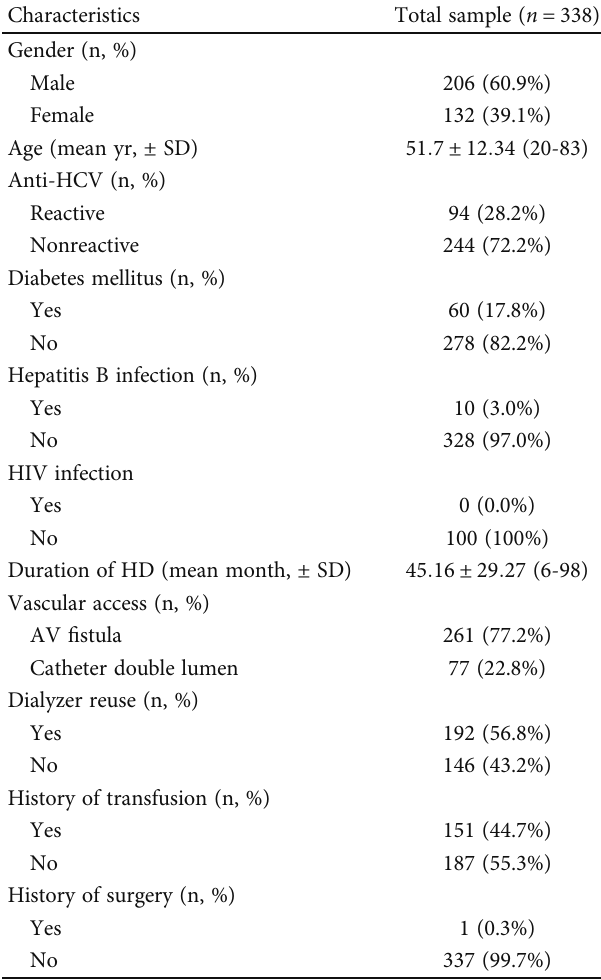
Table 1: Characteristic of patients.